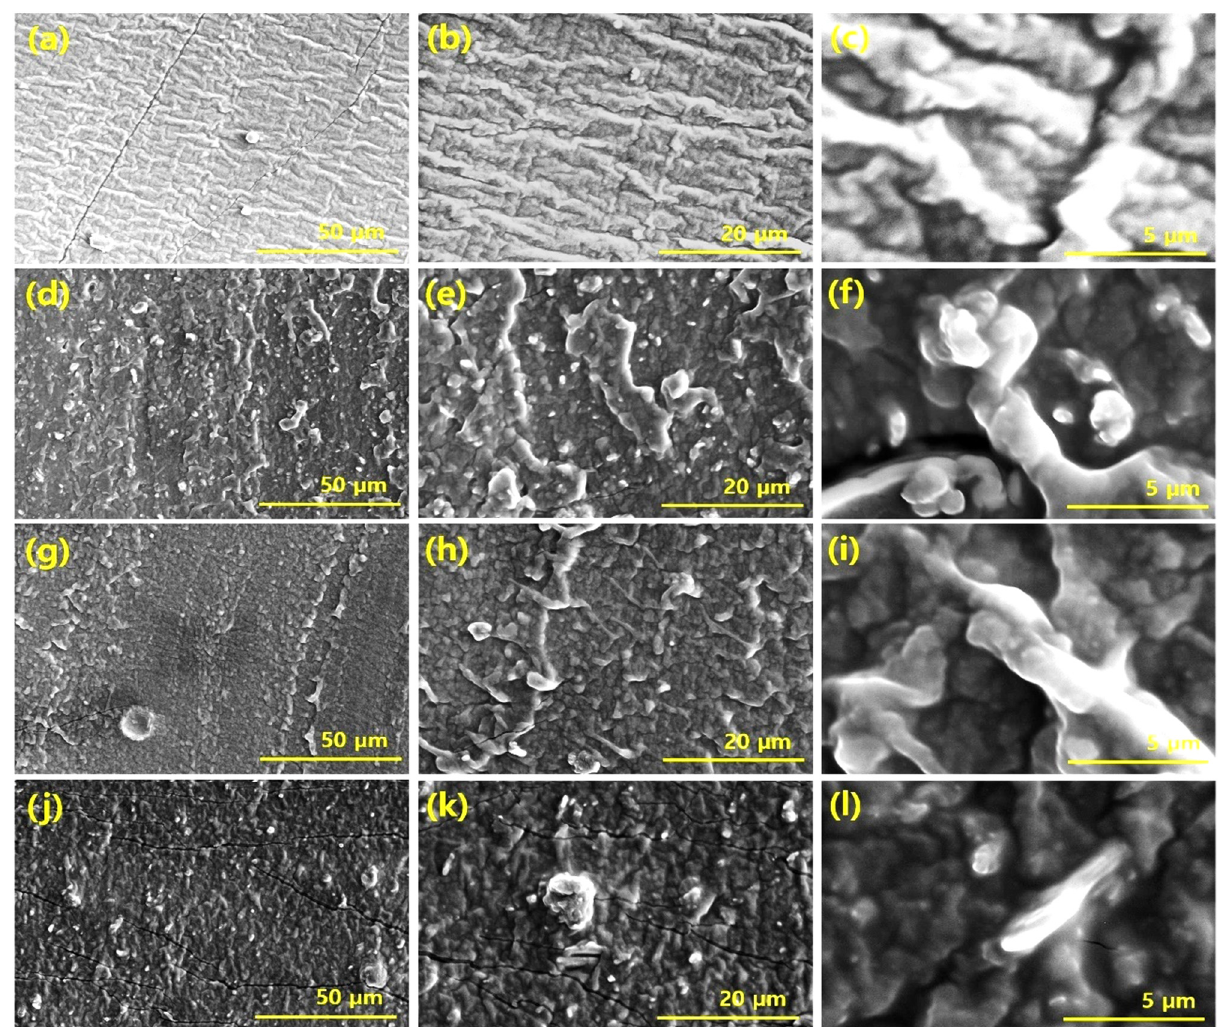
Figure 3. SEM micrographs of different composites; ( a−c ) virgin, ( d−f ) GNP composites, ( g−i ) Fe 2 O 3 composites, ( j−l ) hybrid composite.